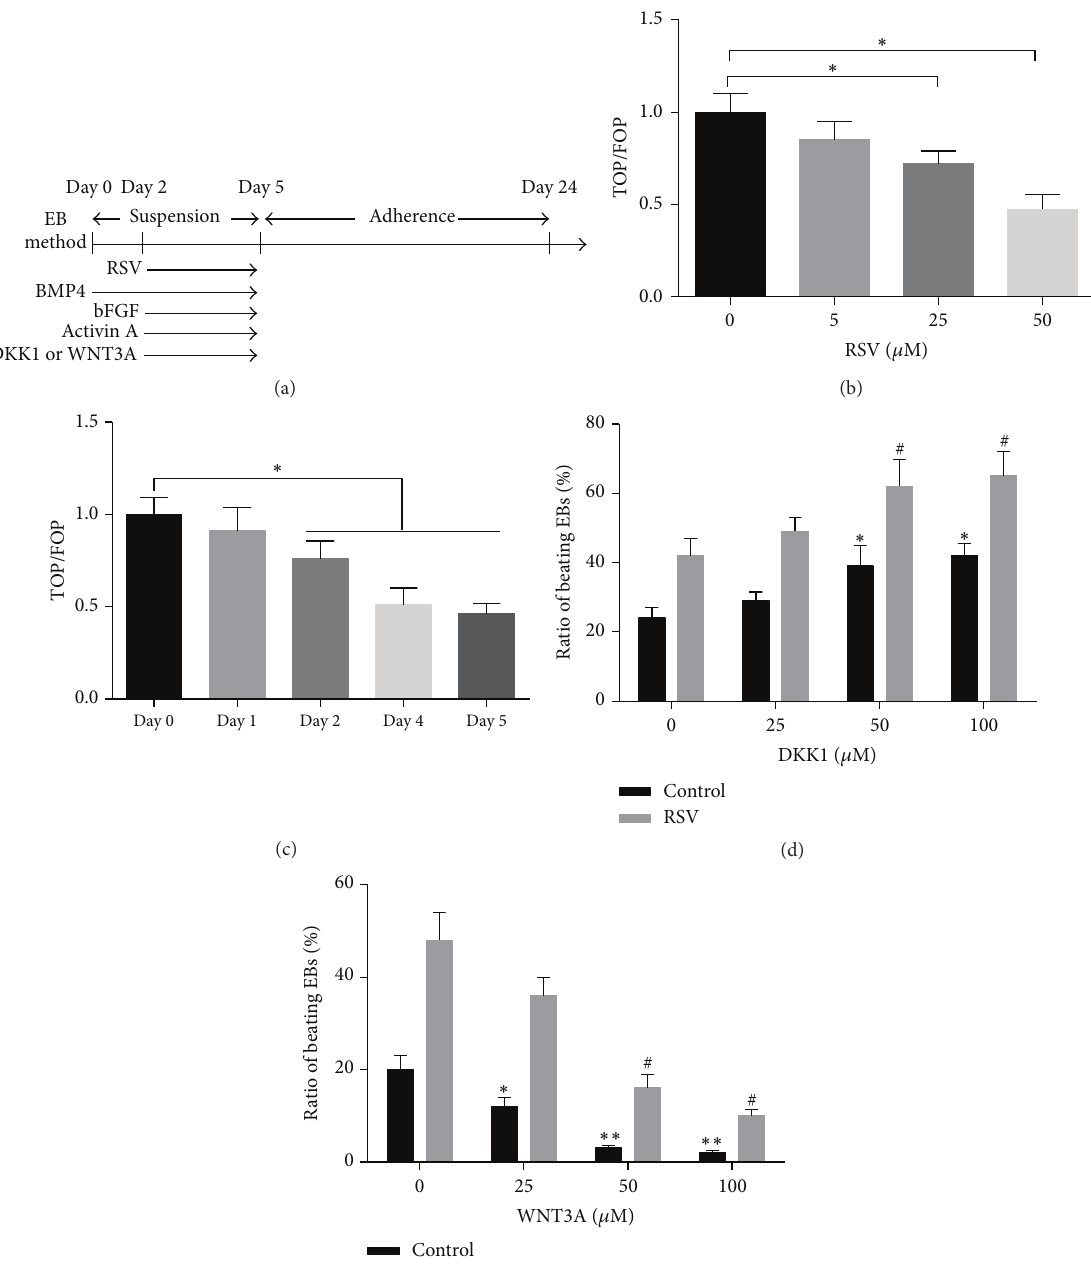
Figure 3: RSV enhances CM differentiation partially through inhibition of WNT signal pathway. (a) An outline describing the administrations of pathway modulators during CM differentiation. (b) TOP Flash assay of human iPSCs treated with different concentrations of RSV in suspension culture condition at day 4. (c) From day 0 to day 5, TOP Flash assays were performed, respectively, after 50 𝜇 M RSV incubation. (d, e). The effects of different concentrations of DKK1, WNT inhibitor (d) and WNT3A, WNT activator (e) on the ratio of beating EBs were evaluated on day 24 ( 𝑛 = 100 ). Data represent the mean ± s.d. of three biological replicates. ∗ 𝑃 < 0.05 compared with control; # 𝑃 < 0.05 compared with RSV